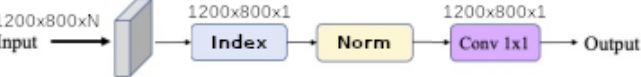
Figure 10. Optimized model for standard indices